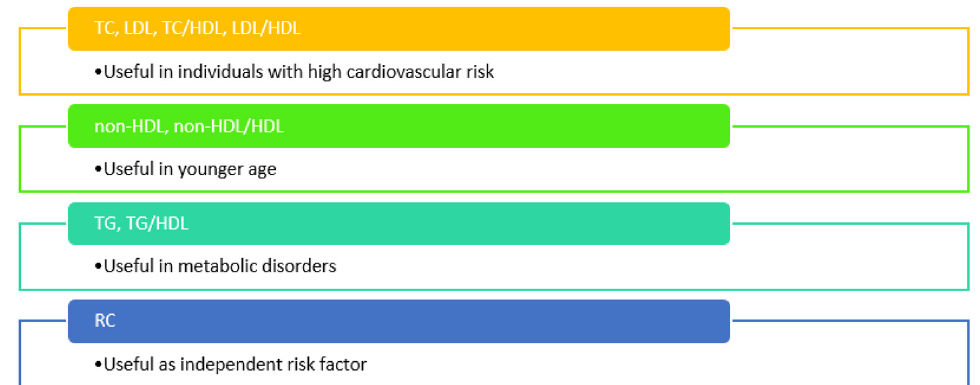
Figure 6. Lipid parameters and ratios associated with arterial stiffness in particular conditions (TC = total cholesterol, TG = triglycerides, LDL = low-density lipoprotein cholesterol, HDL = high-density lipoprotein cholesterol, non-HDL = non-high-density lipoprotein cholesterol, RC = rem- nant